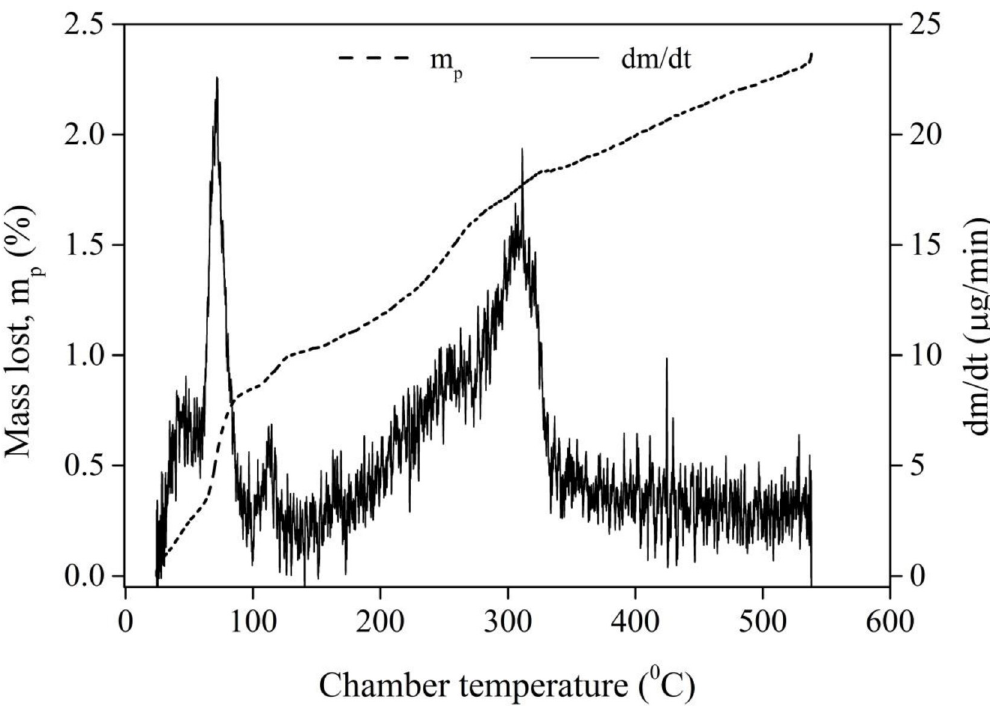
Fig 6. Variations, with the TGA/DTA chamber temperature (horizontal axis), of the percentage (primary vertical axis) and rate of (secondary vertical axis) mass lost from the crusted sample. The results with the unused sample are not included